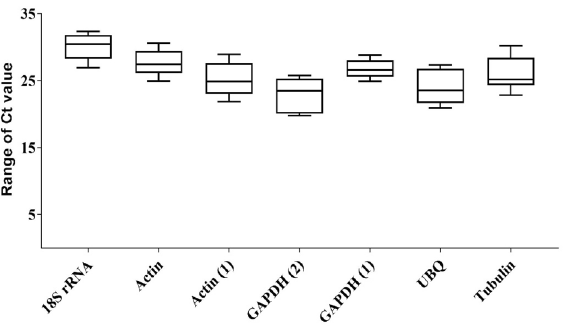
Figure 1. Ranges of expression of the seven selected reference genes in all analyzed samples. The whisker box plots represent the cycle threshold numbers (Ct value) of the seven reference genes. The horizontal lines inside the boxes are the median values, and the whiskers of the boxes indicate the minimum and maximum.